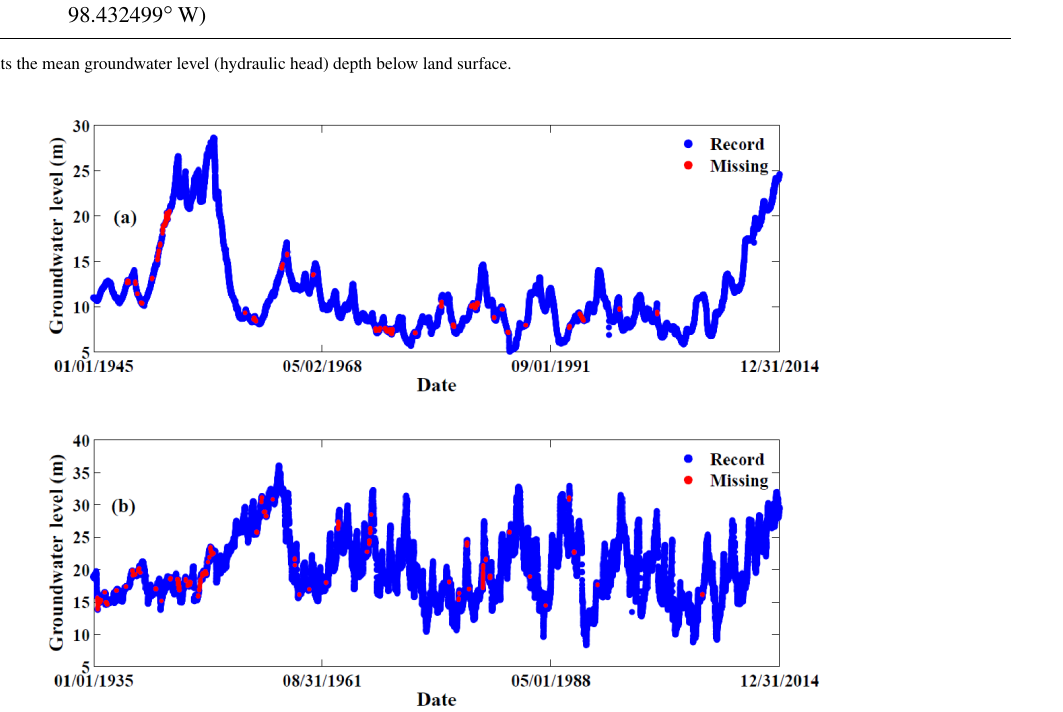
Figure 1. Groundwater level time series data of (a) Well 1 and (b) Well 2.